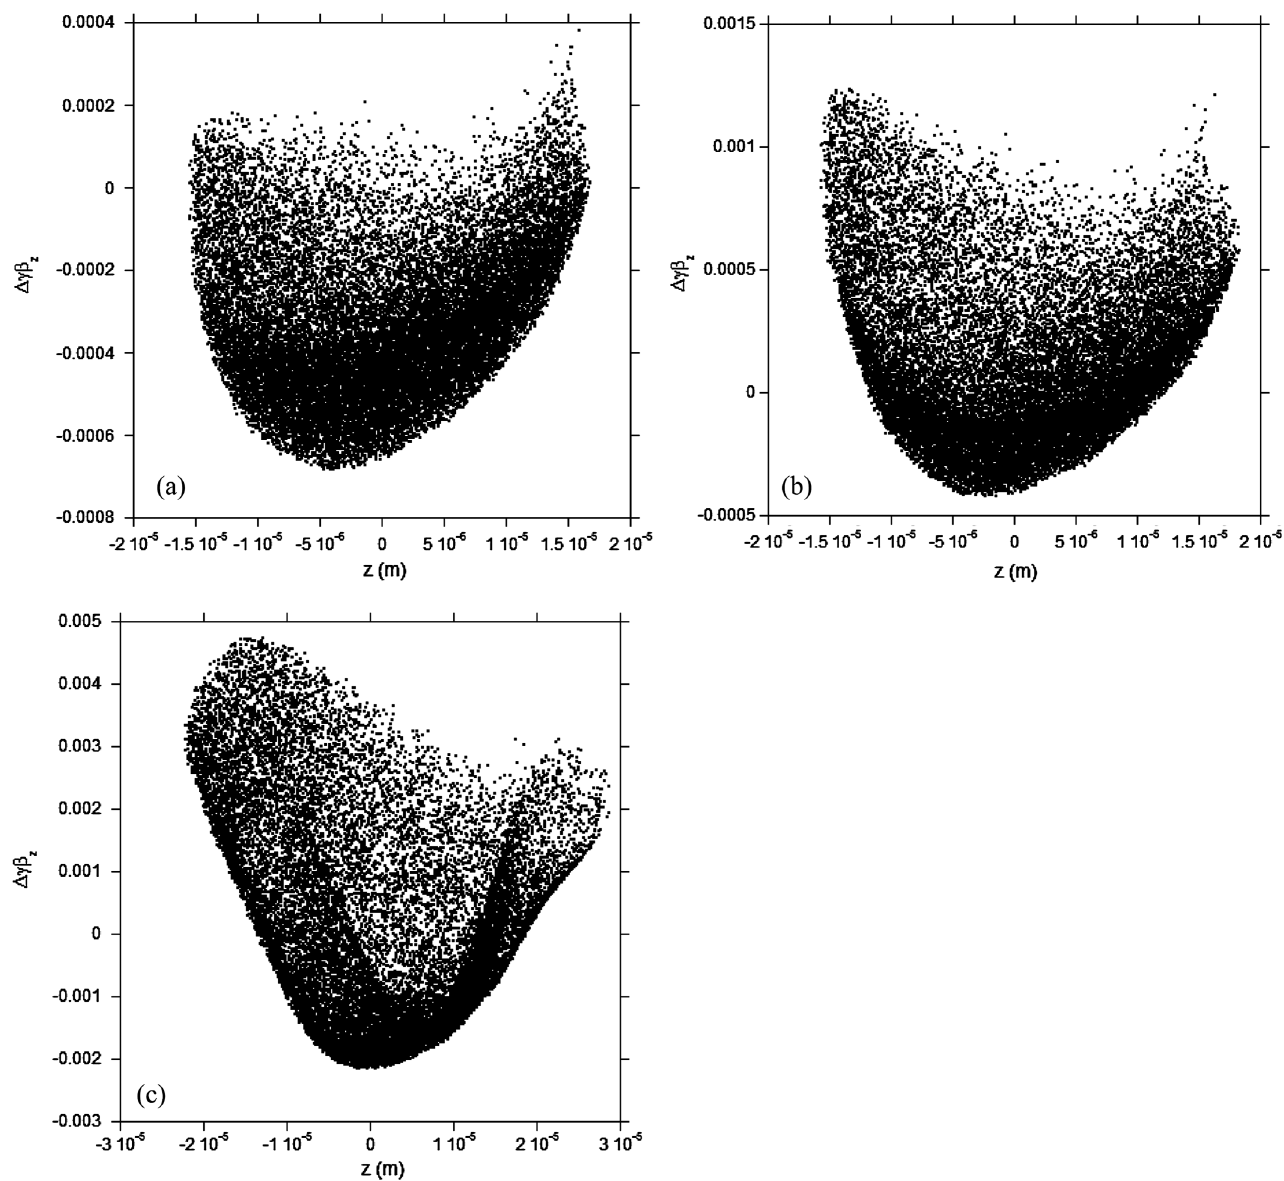
FIG. 7. (a) Final longitudinal phase for a 100 pC bunch compressed in EEX case C— 2 : 7 (cid:3) m longitudinal emittance, (b) final longitudinal phase for a 200 pC bunch compressed in EEX case C— 5 (cid:3) m longitudinal emittance, and (c) final longitudinal phase for a 1 nC bunch compressed in EEX case C— 33 (cid:3) m longitudinal